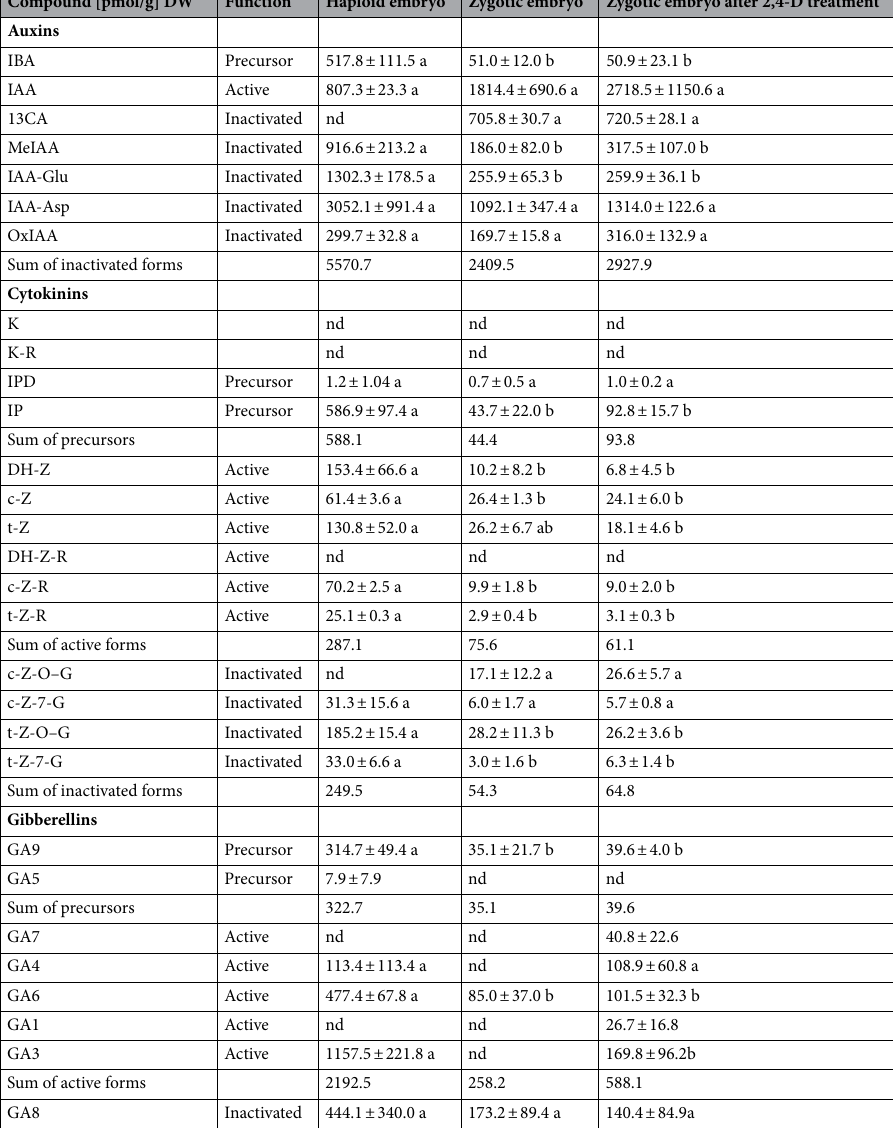
Table 2. Hormonal profile of cv. ‘Akt’ embryos. Values are means of three replicates ± standard error. Means indicated by the same letter do not significantly differ at P < 0.05 according to one-way ANOVA and post hoc Duncan’s test.